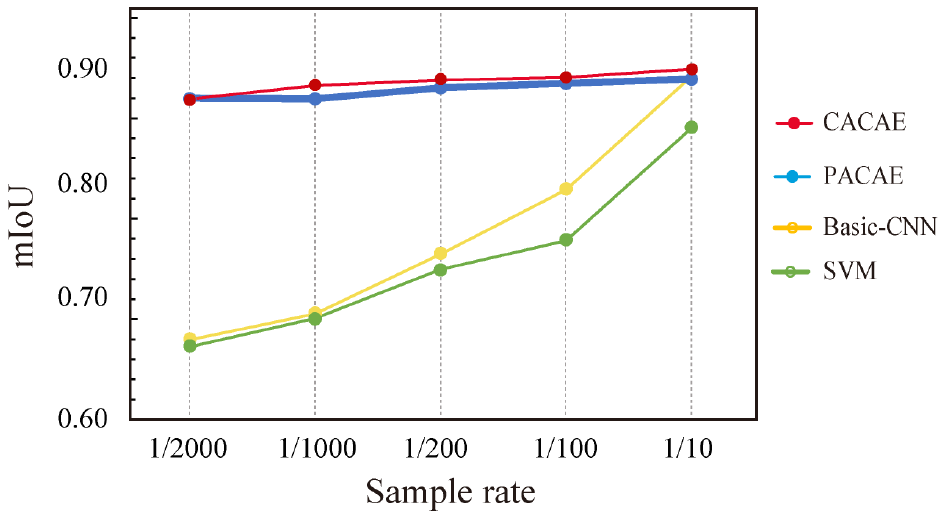
Figure 11. The trend of MIoU at different sampling rates. Table 7. Comparison table of MIoU predicted by all models at different sampling